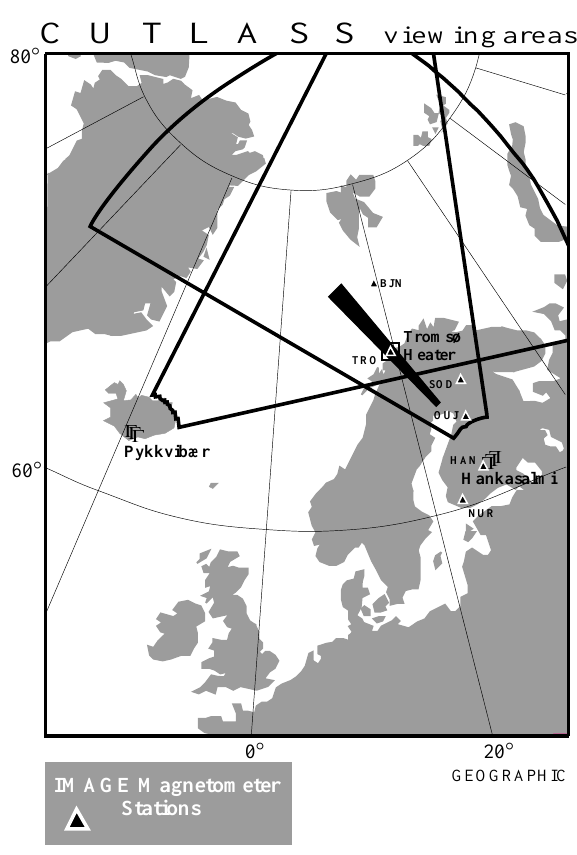
Fig. 1. The CUTLASS HF radar fields of view during their stan- dard (common) mode of operation. The bistatic system consists of radars located at Pykkvibær, Iceland and Hankasalmi, Finland. Also indicated are a number of magnetometers in the IMAGE network. The shaded area indicates the extent of the high spatial and tem- poral resolution beam 5 of the Finland radar in the special OUCH experimental mode. Data included in this study were exclusively measured on this beam, which overlays the high power heating fa- cility in Tromsø,